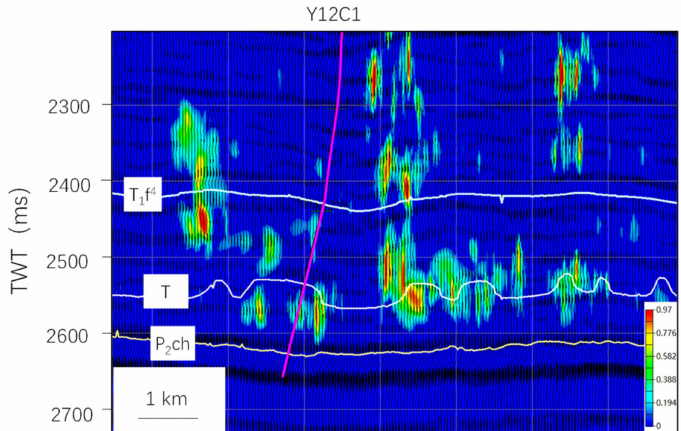
Figure 9. Seismic section with energy (green-orange color) across well Y12C1 (the green-orange blocks indicate the fault damage